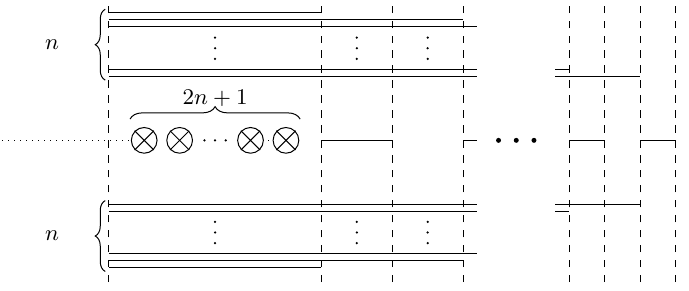
Figure 55. Higgs branch brane con(cid:12)guration for M H the closure of the maximal nilpotent orbit of so (2 n + 1). There are n D3-branes in the leftmost interval between half D5-branes. The number of D3-branes then decreases by one on each next pair of intervals to the right, until it reaches zero. family of quivers are computed in appendix C and are checked to correspond to the union M [ A 2 n (cid:0) 1 . If an S-Duality is performed, the brane system in (cid:12)gure 57(b) H = A 2 n (cid:0) 1